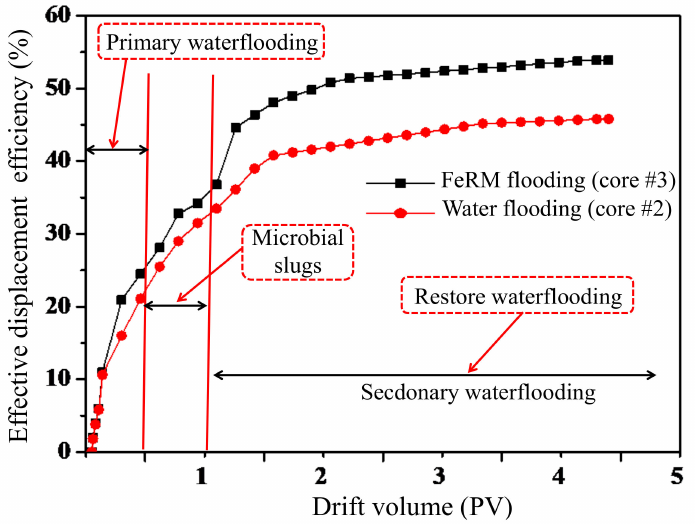
Figure 4. The enhanced oil recovery by FeRM in core displacement